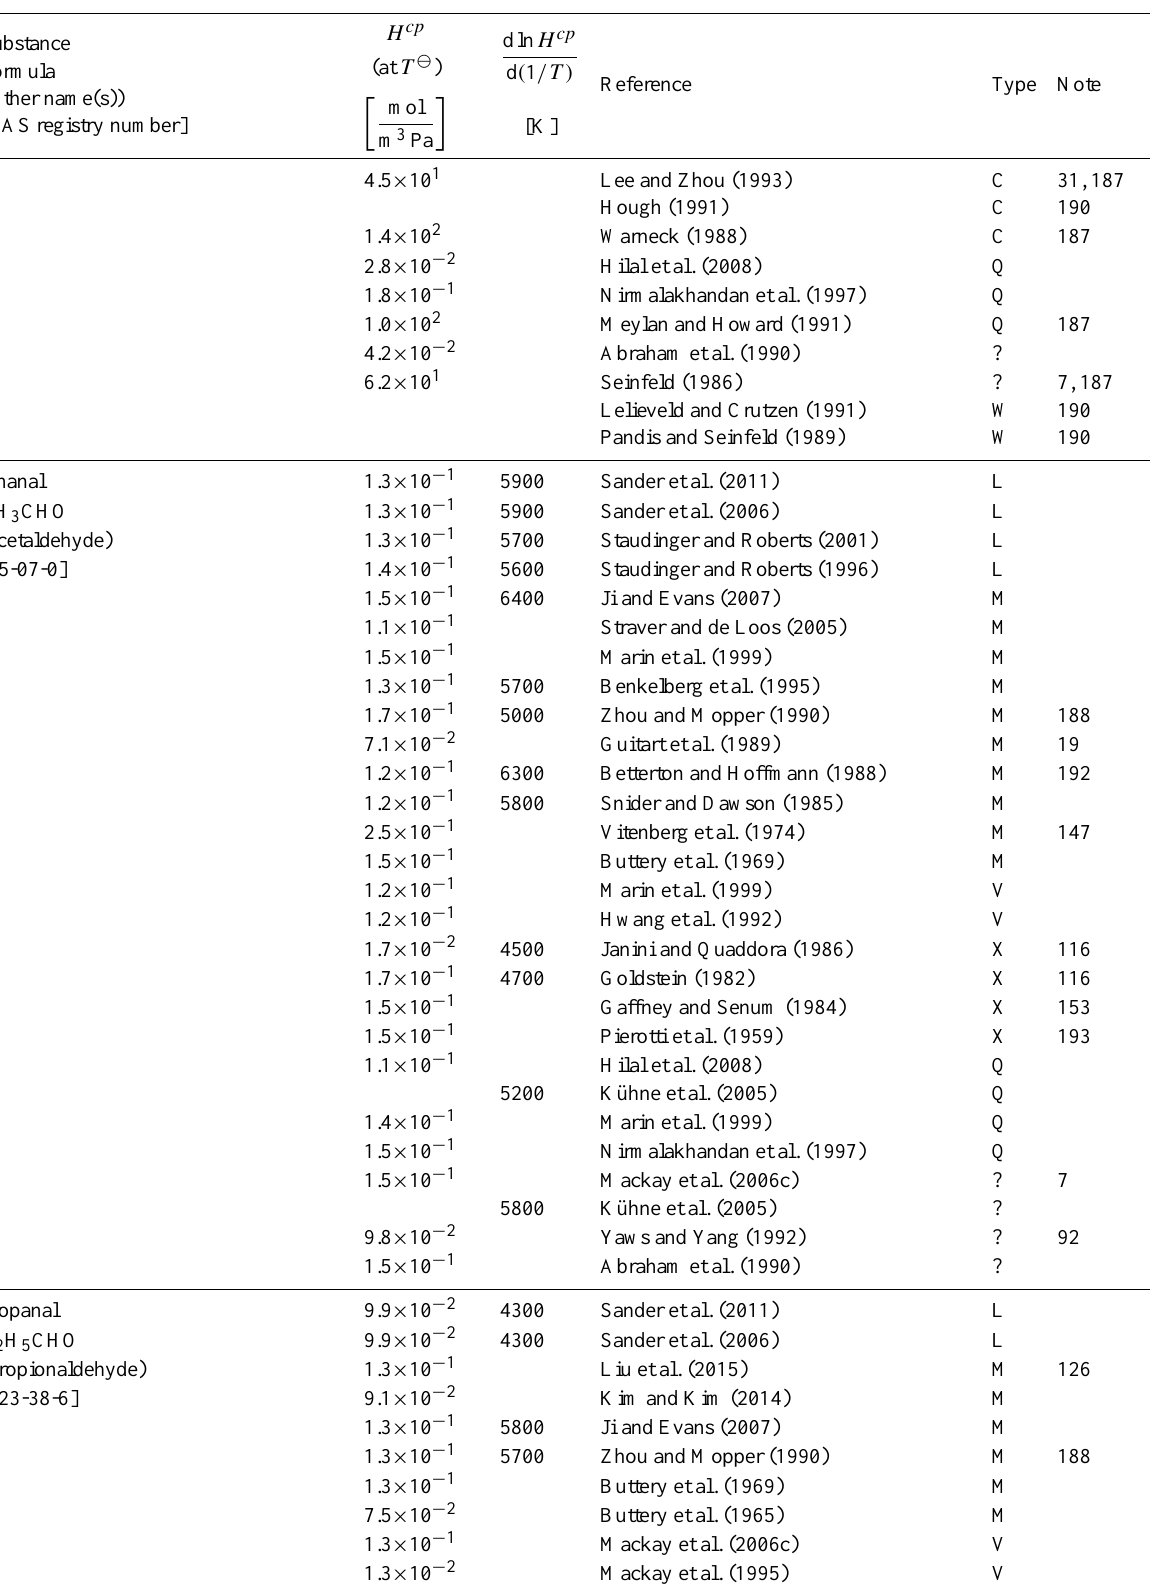
Table 6: Henry’s law constants for water as solvent